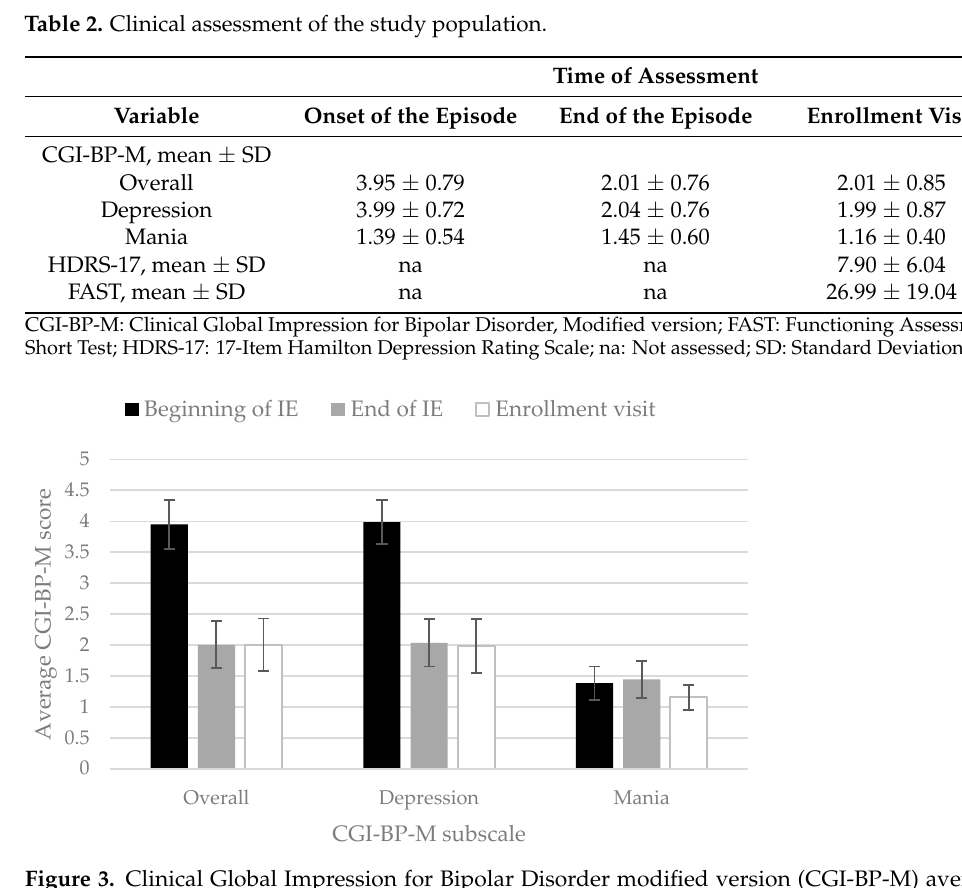
Figure 3. Clinical Global Impression for Bipolar Disorder modified version (CGI-BP-M) average scores (overall, depression and mania subscales) at the beginning of the index episode (IE) of major depression, end of IE, and at enrollment.